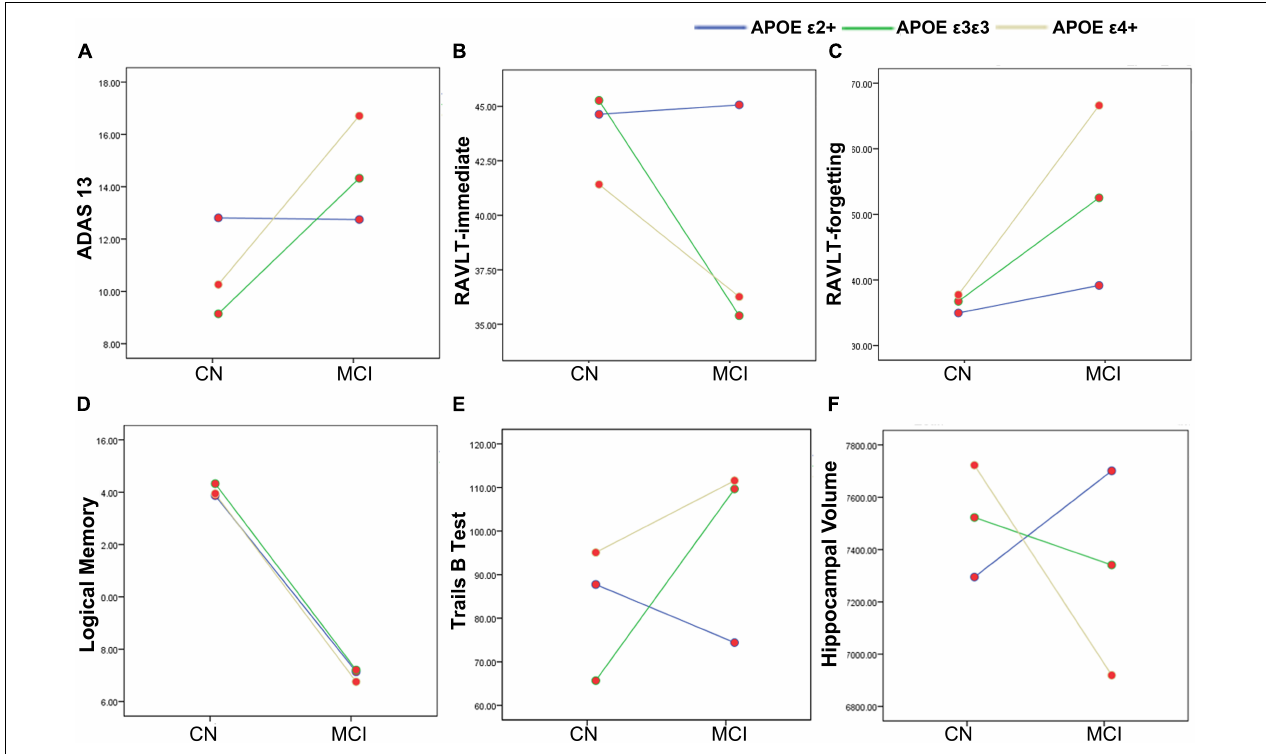
FIGURE 1 | The main and interactive influences of diagnosis and apolipoprotein E ( APOE ) genotype on cognitive function and hippocampal volume. (A,B,E,F) Interactive influence of diagnosis and APOE genotype on the hippocampal volume and scores of ADAS13, RAVLT-immediate, and Trails B test. Compared to the APOE ε 3 ε 3 and ε 4 + genotypes, the APOE ε 2+ genotype show more stable cognitive function and hippocampus volume during the CN to MCI period. (C,D) Main influences of diagnosis on the scores of RAVLT-forgetting and Logical Memory tests. The MCI group show lower logical memory and more RAVLT-forgetting rate as compared to the CN group. CN, cognitively normal; MCI, mild cognitive impairment; ADAS13, Alzheimer’s disease (AD) assessment scale–13-item cognitive subscale; RAVLT, Rey Auditory Verbal Learning Test.